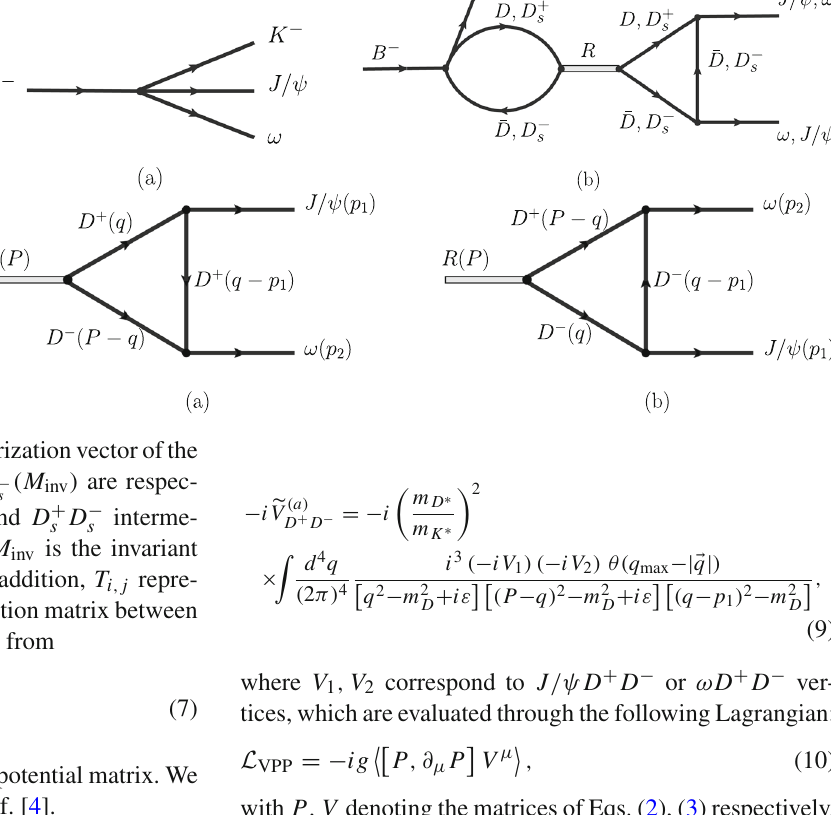
Fig. 4 Triangle diagram with D + D − intermediate state. The panels a , b are essentially the same but with J /ψ ad ω